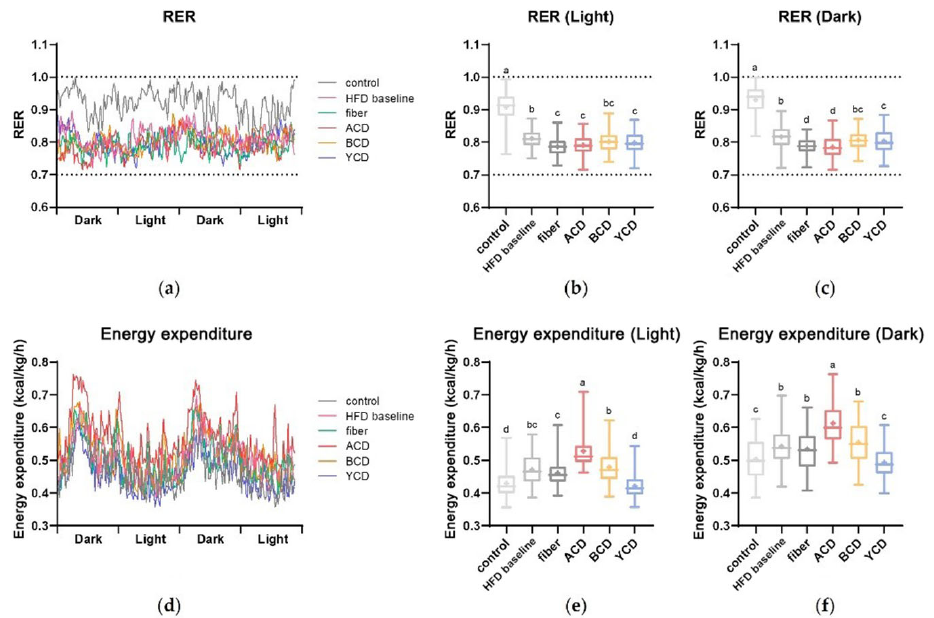
Figure 5. α‐ CD supplementation promoted energy expenditure, whereas α‐ CD and γ‐ CD improved the fat supply ratio. ( a – c ) Respiratory exchange ratio (RER) and ( d – f ) energy expenditure of C57BL/6J mice in 48 h. n = 3. Control, low-fat diet; HFD baseline, high-fat diet without cellulose; fiber, high-fat diet; ACD, high-fat diet that replaced α -CD with cellulose; BCD, high-fat diet that replaced β -CD with cellulose; YCD, high-fat diet that replaced γ -CD with cellulose. Data are expressed as means ± SEM. Values not sharing a common superscript differ significantly among groups ( p < 0.05, ANOVA).